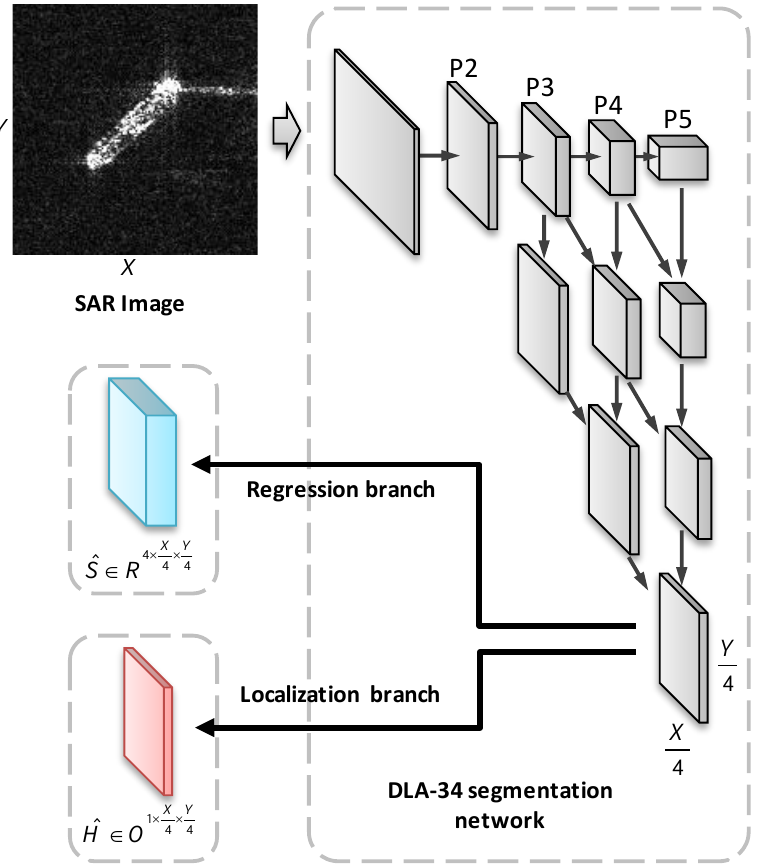
Figure 1. The architecture of ShipDet.